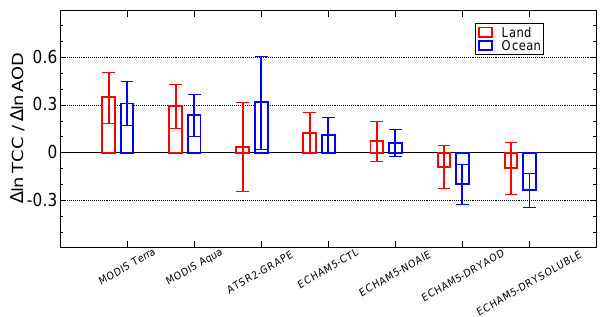
Fig. 1. Slope of the relationship ln TCC vs. ln AOD (see text for details). The weighted average for four seasons and all six land regions (red) and eight ocean regions (blue) is shown, with the vari- ability as error bar. Error bars for the satellite data also include the inter-annual variability among the eight, three and four years, for MODIS Terra, MODIS Aqua, and ATSR2-GRAPE,